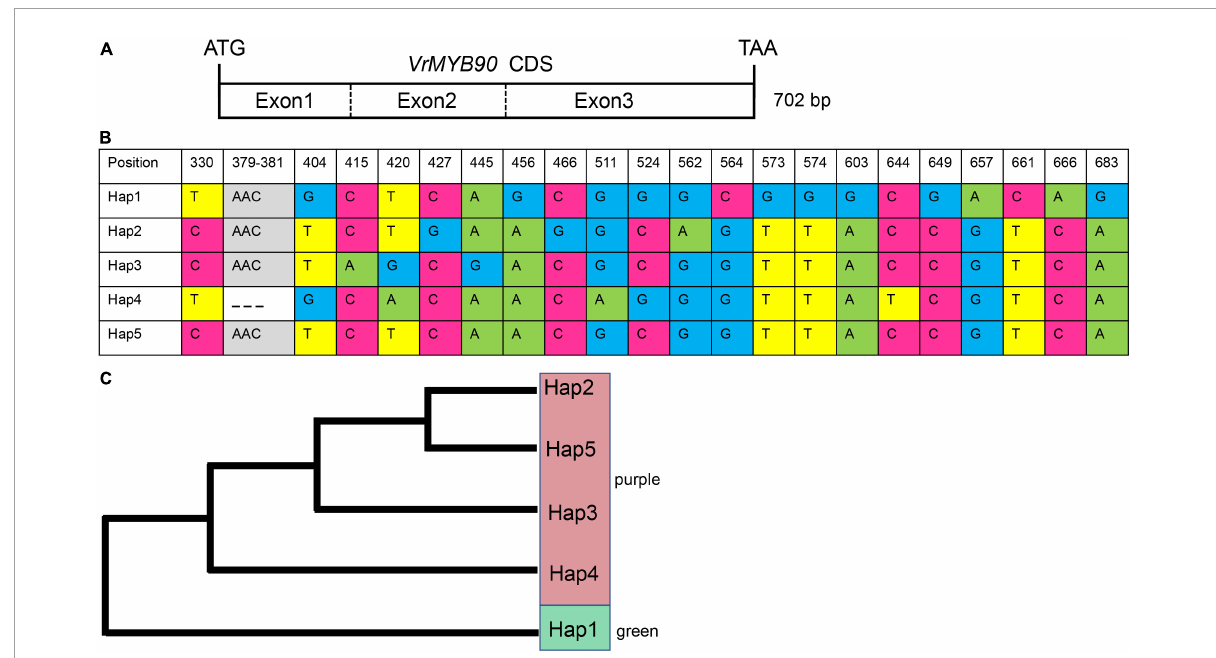
FIGURE5 Haplotype analysis of VrMYB90 in a panel of 124 mungbean accessions. (A) Coding sequence (CDS) structure of VrMYB90 . (B) Five haplotypes of VrMYB90 discovered in 124 mungbean accessions. Nucleotides are labeled with colors and deletions are indicated by dashed lines. (C) Phylogenic tree of five haplotypes of VrMYB90 constructed by the neighbor-joining method.